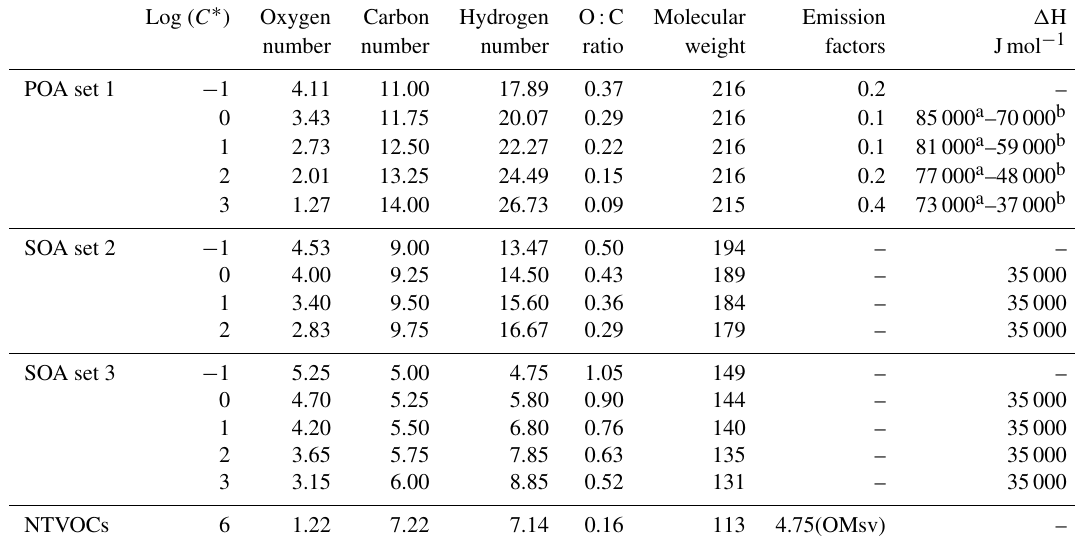
Table 1. Properties of the VBS space. Oxygen numbers for each volatility bin were calculated using the group contribution of Donahue et al. (2011). Hydrogen numbers were calculated from the van Krevelen relation (Heald et al.,